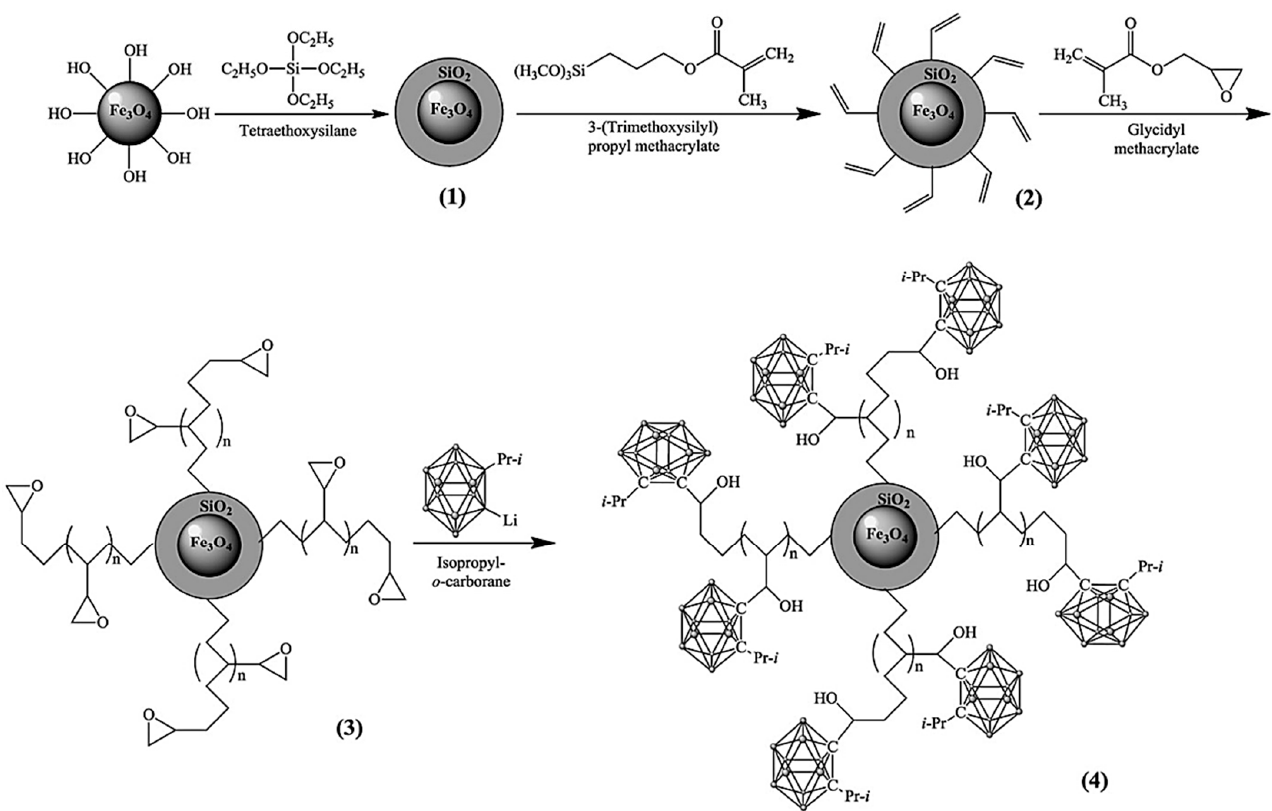
Figure 8. Functionalization scheme for Fe 3 O 4 MNPs with carborane immobilization. Reprinted from ref. [354], with permission from Elsevier, 2020.